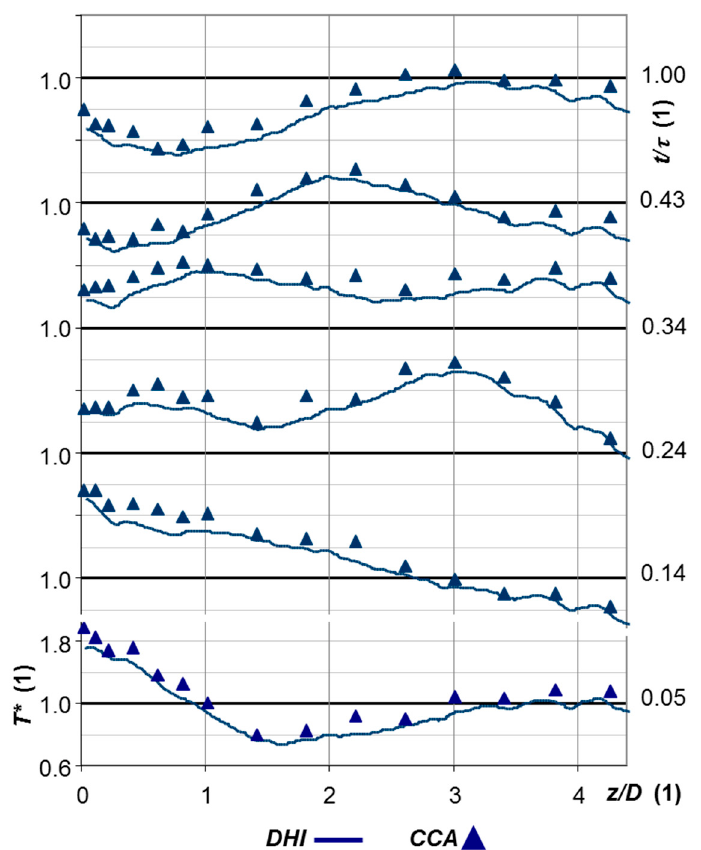
Figure 6. Axis temperature development, depending on the distance from the actuator orifice; curves correspond to DHI and triangles to the CCA experiments; the DHI results are obtained as mean values along the z -axis. The CCA results are measured at z = 0.